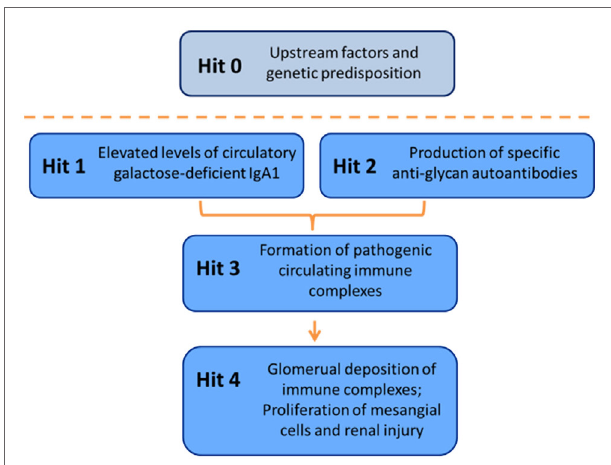
FiGURe 7 | Multi-hit hypothesis for pathogenesis of igAN . Several processes are involved in development of IgAN. Circulatory Gd-IgA1 (Hit 1) is recognized by Gd-IgA1-specific autoantibodies (Hit 2) that leads to formation of pathogenic Gd-IgA1-containing circulating immune complexes (Hit 3). Some of these complexes reach the renal glomeruli to bind to mesangial cells and activate them, thereby inducing renal injury (Hit